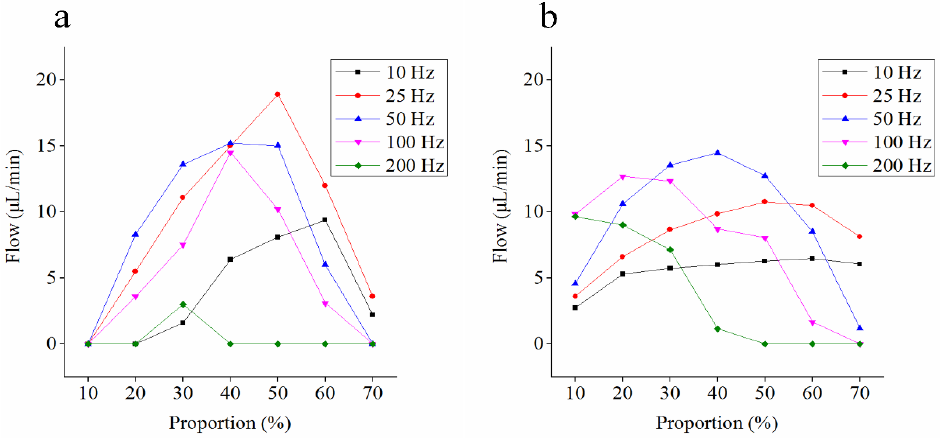
Figure 12. Comparison of the theoretic flow ( a ) and experimental flow ( b ) under different conditions.